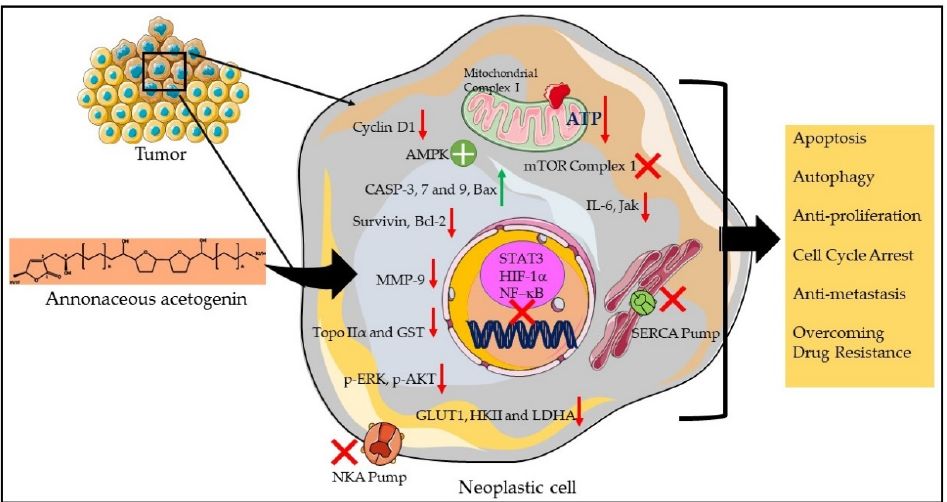
Figure 3. The probable acetogenins-rich A. chlorantha extracts induced antitumor mechanism. Red arrow indicates inhibition/reduction, green arrow indicates increase/promotion, green circle represents activation, and red cross indicates inhibition of proteins/complexes.